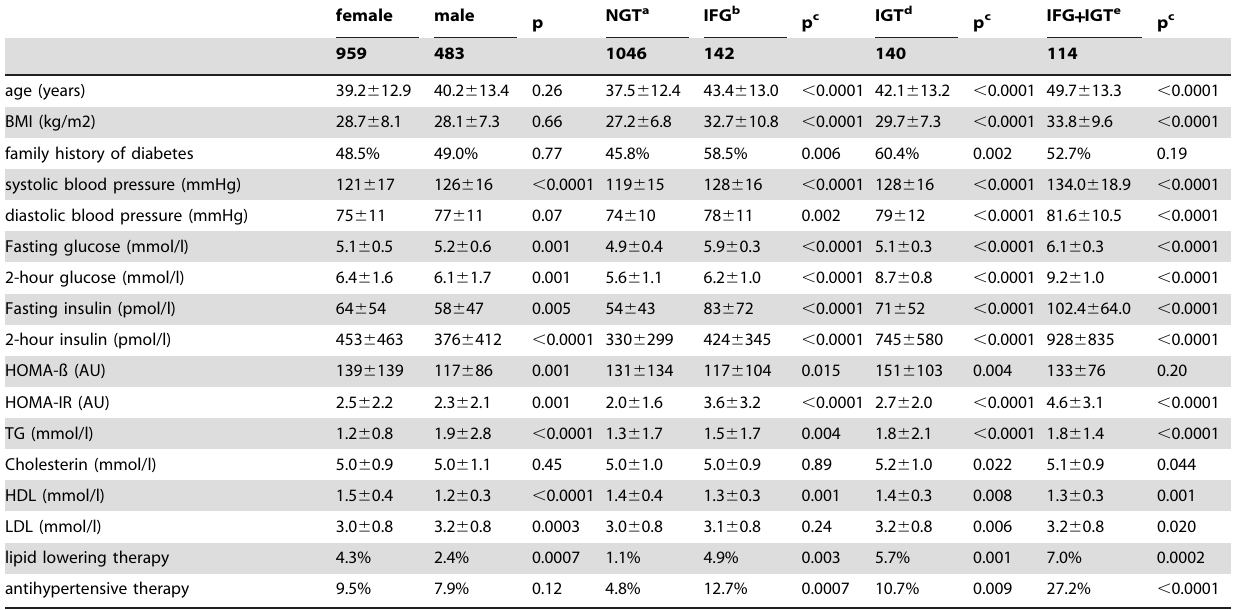
Table 1. Characteristics of the study